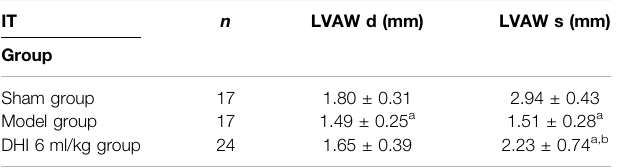
TABLE 3 | The effect of DHI on end-diastolic and end-systolic ventricular intimal thickness of acute myocardial infarction model rats ( (cid:1) x ±s). IT n